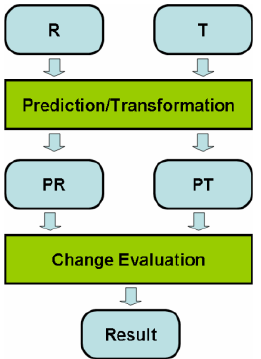
Figure 1. Change detection between two images.